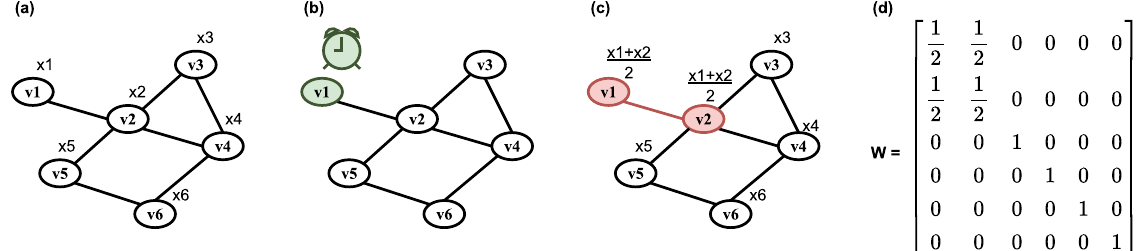
Figure 1. ( a ) Gossip averaging with asynchronous time model performed on a graph, where each node v i is assigned a value x i . ( b ) At a time T k , one of the clocks ticks to signify that the corresponding node ( v 1 ) will perform an averaging scheme. ( c ) The node selects a neighbour ( v 2 ), and both nodes replace their values with the average of the two. ( d ) This is equivalent to multiplying the vector of all values x by the weight matrix W